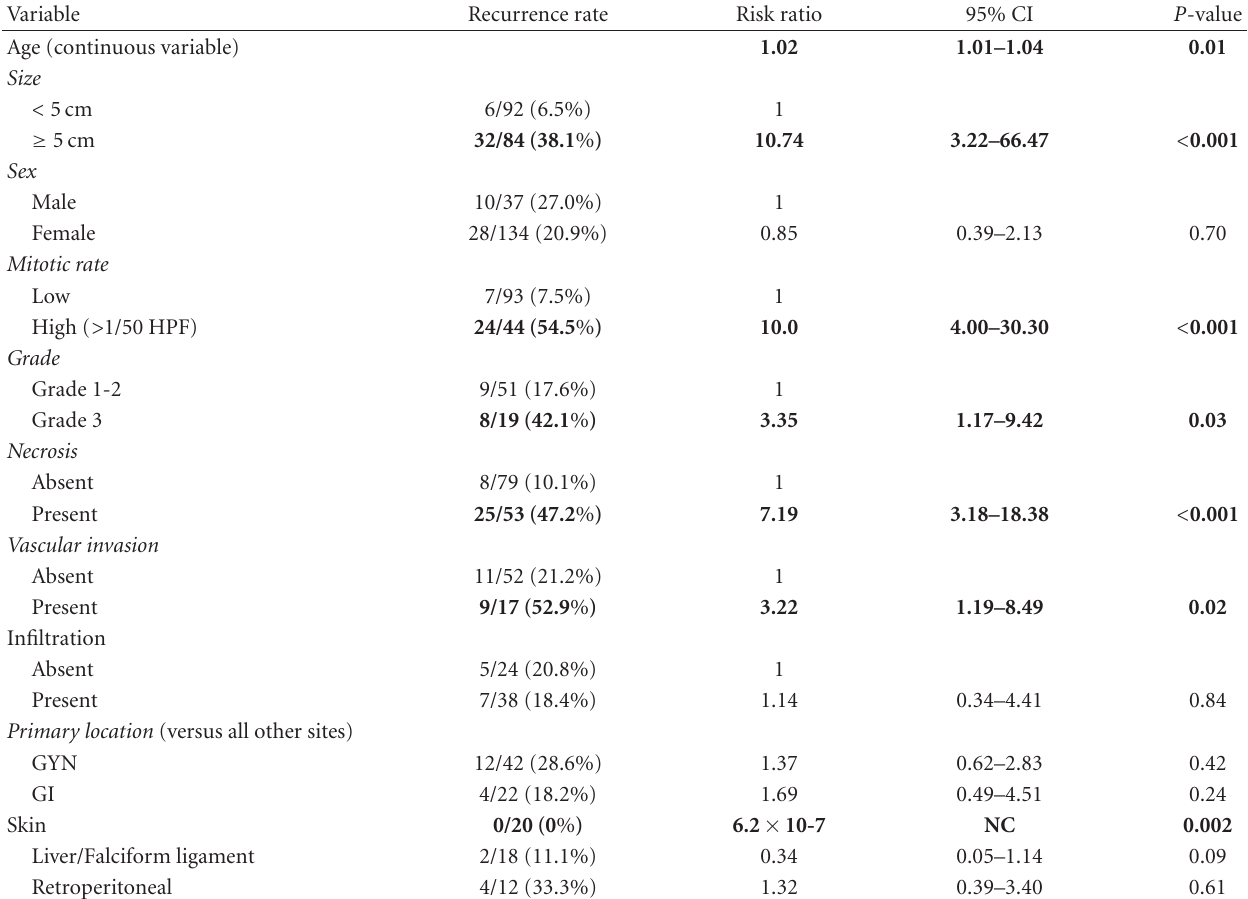
Table 2: Univariate analysis of clinical and histologic factors related to PEComa-NOS recurrence.